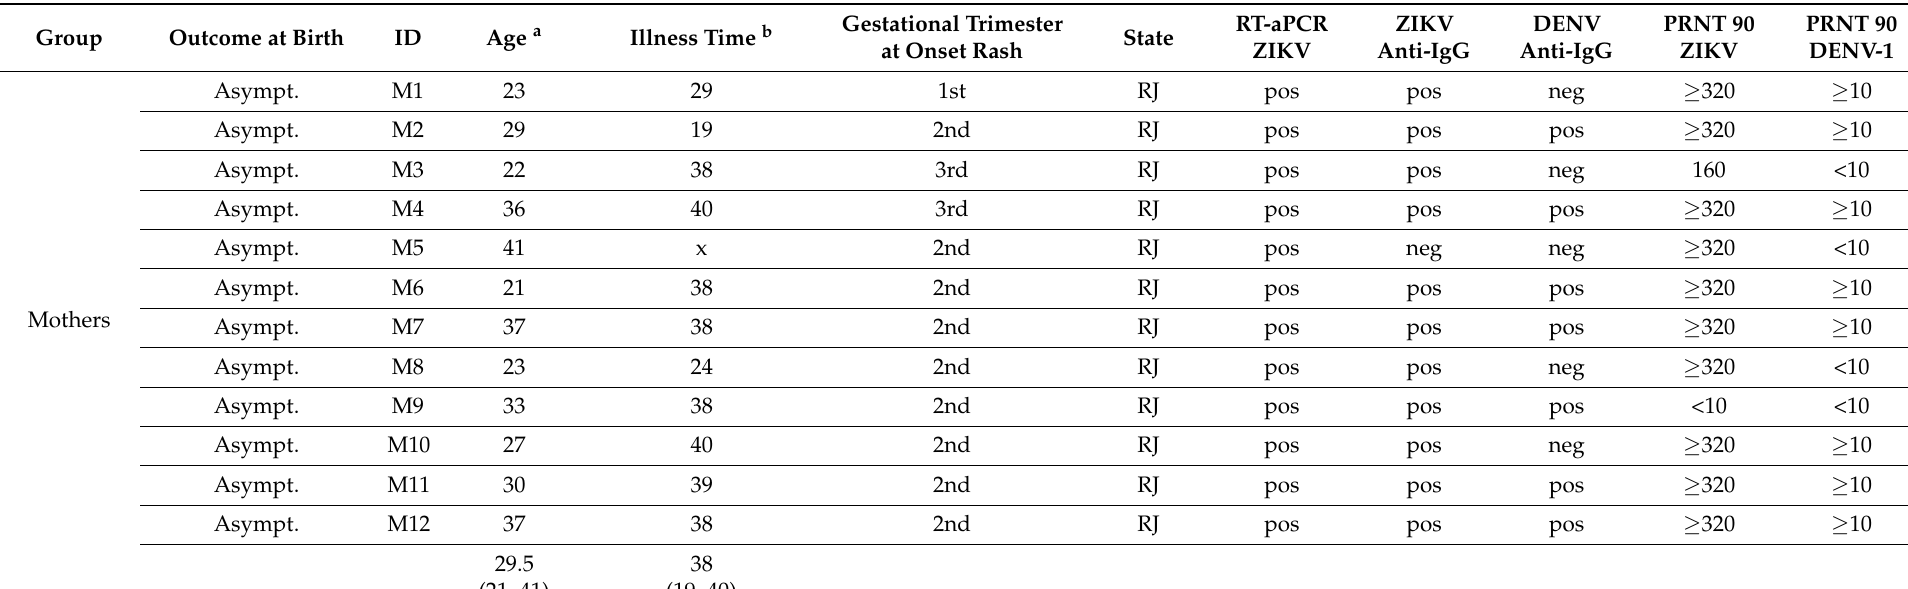
Table 1. Characteristics of the recovered mothers infected to Zika virus during pregnancy recruited from 2018 to 2019. Gestational Trimester RT-aPCR ZIKV DENV PRNT 90 PRNT 90 Group Outcome at Birth ID Age a Illness Time b State at Onset Rash ZIKV Anti-IgG Anti-IgG ZIKV DENV-1 Asympt. M1 23 29 1st ≥ 10 Asympt. M2 ≥ 320 ≥ 10 Asympt. M3 22 38 3rd RJ neg 160 <10 Asympt. M4 36 ≥ 10 Asympt. M5 41 x 2nd RJ pos neg neg ≥ 320 <10 Asympt. M6 21 38 2nd ≥ 10 Mothers Asympt. M7 37 ≥ 320 ≥ 10 Asympt. M8 23 24 2nd RJ pos pos neg ≥ 320 <10 Asympt. M9 33 38 2nd pos <10 <10 Asympt. M10 27 40 2nd RJ pos pos neg ≥ 320 ≥ 10 Asympt. M11 30 39 2nd RJ pos pos pos ≥ 320 ≥ 10